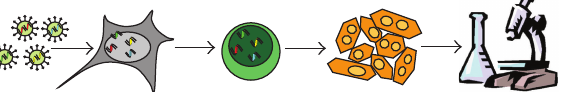
Figure 1: iPS cells as model to study metabolic liver diseases. Induced pluripotent stem cells (iPSCs) can be generated using retro- or lentiviral constructs expressing the canonical repro- gramming factors Oct4, Klf4, and Sox2 with or without c-Myc. This technique allows the generation of pluripotent stem cells from diseased individuals. Subjection of these iPS cells to hepatic di ff erentiation protocols results in an easily accessible source of disease-specific hepatic cells. Importantly, this technique might pave the way for in depth study of corresponding liver